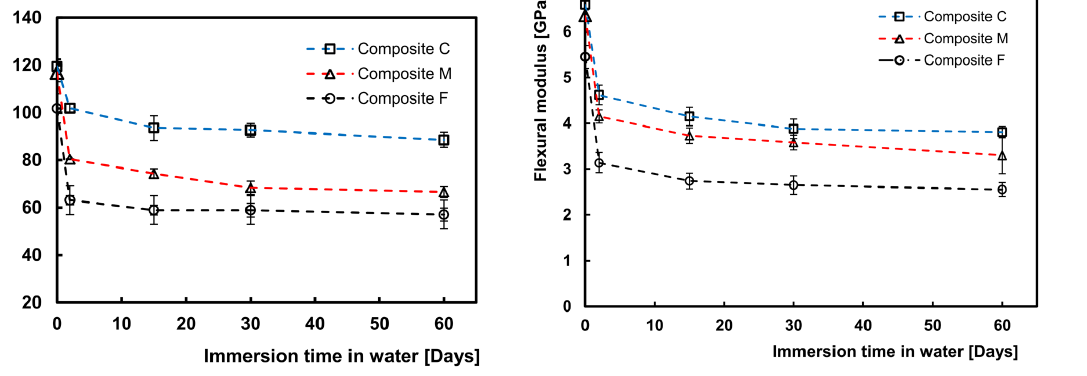
Figure 5. Bending strength versus immersion time in water. Figure 6. Flexural modulus versus immersion time in